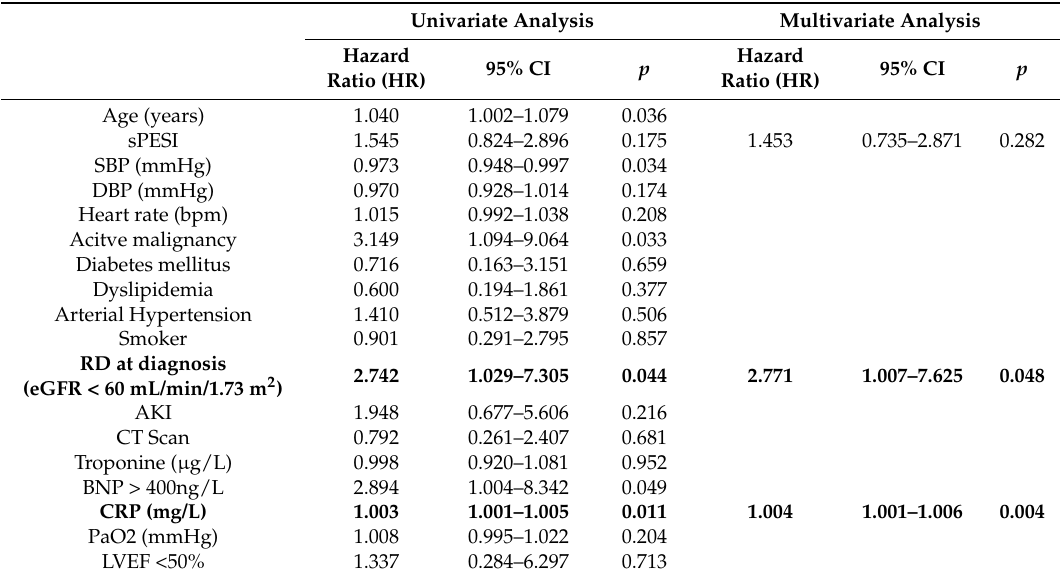
Table 3. Univariate and multivariate analyses for the prediction of 30-day mortality. Univariate Analysis Multivariate Analysis